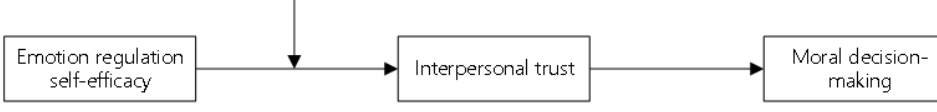
Figure 2. Theoretical